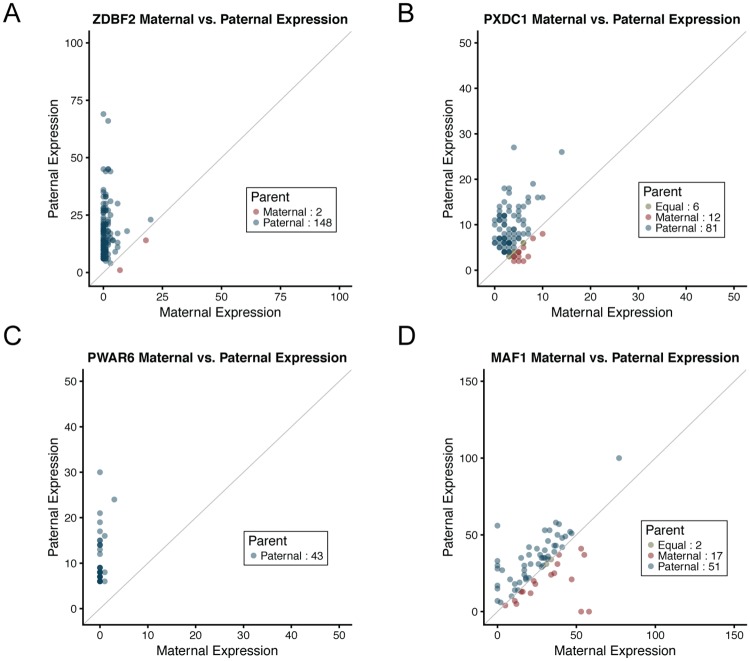
Plots of maternal (x-axis) and paternal (y-axis) gene expression counts for four genes that were significant in the asymmetry test, reflecting more expression from one parental haplotype than the other.Each point represents an individual. The units of x- and y-axis are gene count measures. (A) Maternally imprinted gene ZDBF2 (paternally expressed). Most individuals have expression solely from the paternal haplotype (shown in blue); some individuals have low expression from the maternal haplotype. Two individuals have more maternal expression than paternal expression (shown in red). (B) Maternally imprinted candidate gene PXDC1 (paternally expressed). Most individuals (n = 81) have more paternal expression than maternal expression; a few individuals have expression solely from the paternal haplotype (maternal expression is 0) and a few (n = 12) have more maternal than paternal expression. (C) Maternally imprinted candidate gene PWAR6 (paternally expressed). All 43 individuals have more paternal expression; four also have very low amounts of maternal expression. (D) Asymmetric parental expression MAF1. This gene is likely not imprinted. The numbers of individuals with equal maternal and paternal expression, more maternal expression, or more paternal expression are shown in the legend.